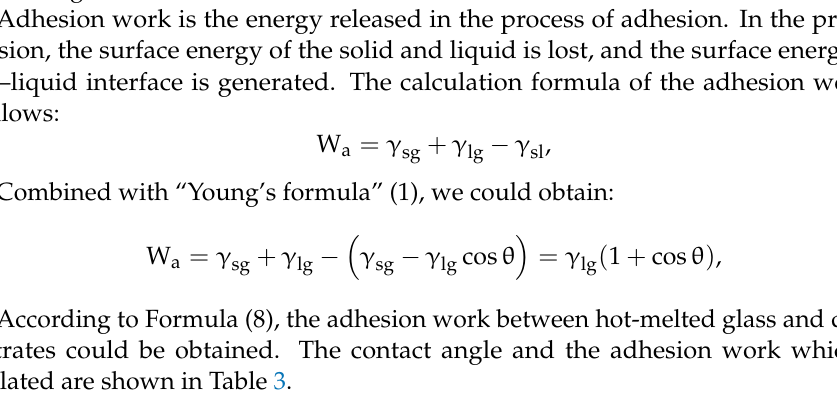
Table 3. Contact angle and adhesion work between hot-melt glass and each substrate